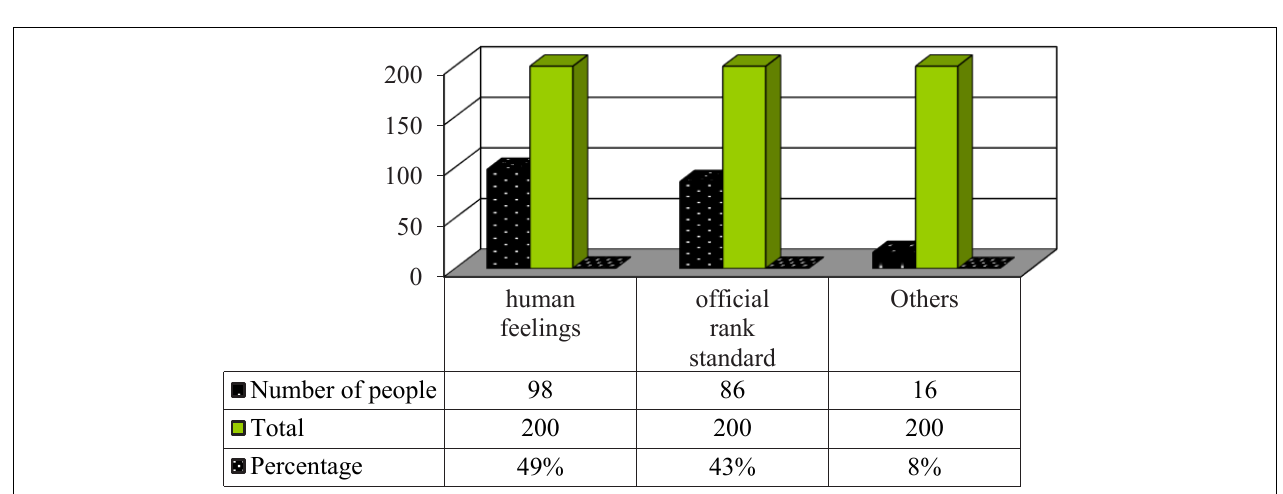
FIGURE 1 | Investigation of factors involved in personal values.